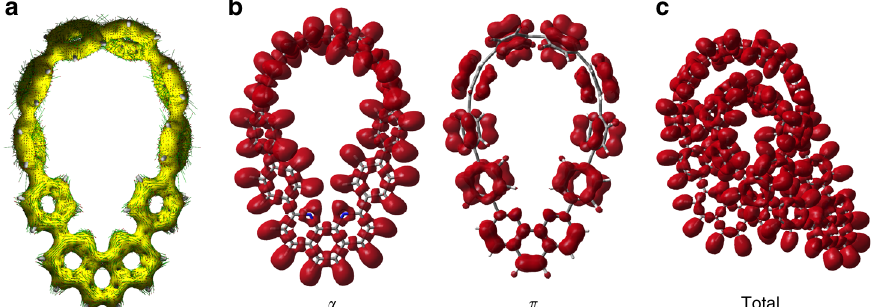
Fig. 4 Electron delocalization evaluation of the energy minimized structures of catenane 1 and monomer 9 . a The ACID plot for monomer 9 . b ELF domains dissected into σ and π contributions in monomer 9 . c the ELF domains in catenane 1 . The vector of external magnetic fi eld used to induce currents is parallel to the line of sight. Small green arrows are computed current density vectors. The π molecular orbitals are listed in Supplementary Table 4. Isovalues for ACID and ELF surfaces are 0.050 a.u. and 0.65 a.u.,